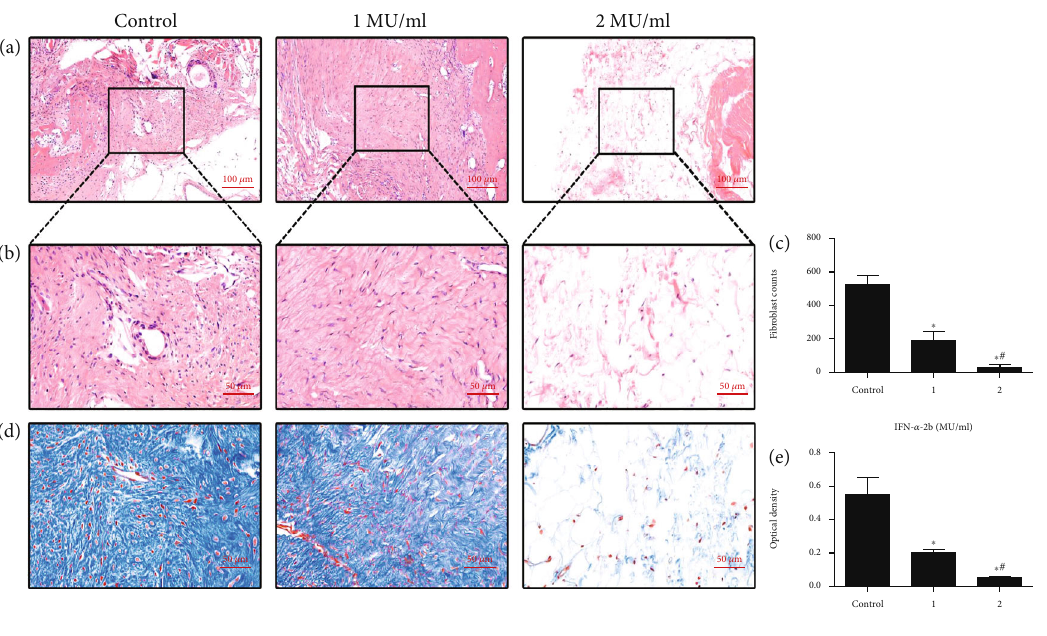
Figure 1: Histological evaluation of joint fi brosis in di ff erent groups. (a, b) HE staining showed fi broblasts in each group of joint fi brotic tissue; (c) the number of fi broblasts decreased with the increase of IFN- α -2b concentration; (d) Masson ’ s staining showed the content of collagen in knee tissues of each group. (e) The results of optical density analysis suggest that IFN- α -2b can e ff ectively reduce the production of collagen. ∗ Compared with the control group. # Comparison between the two groups of IFN- α -2b medications, P < 0 : 05 ( n = 6 e ff ect of the route of administration.